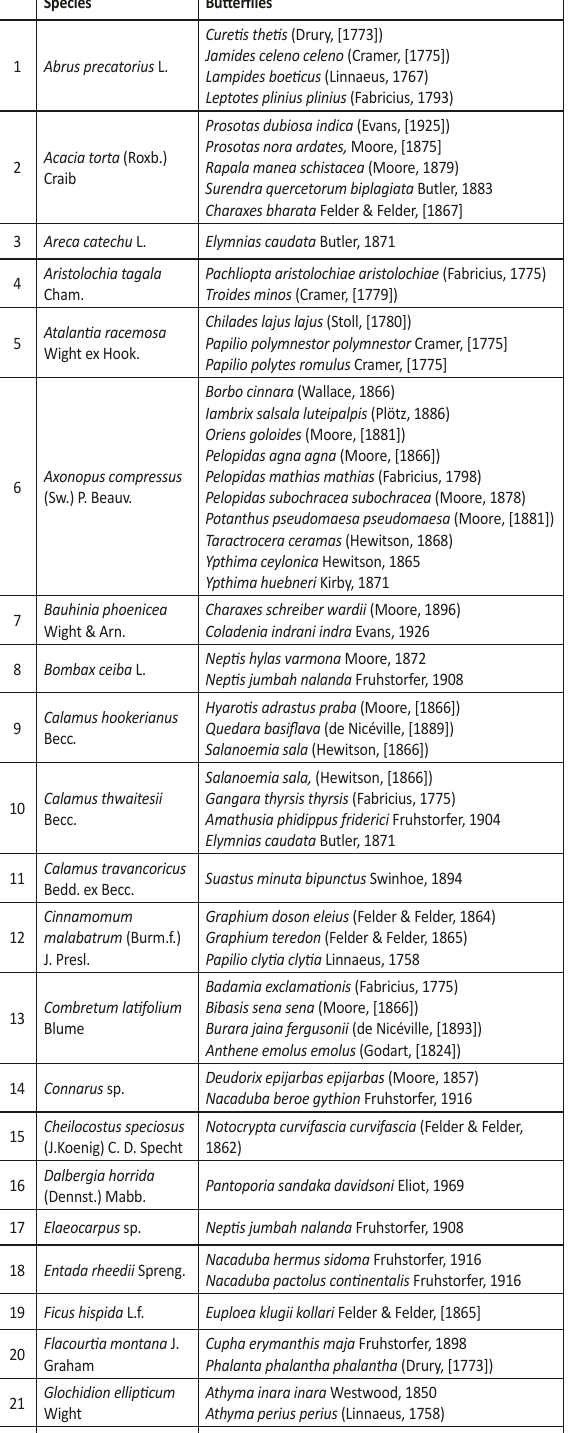
Table 3. List of larval host plants for butterflies of myristica swamp forests, Shendurney WS, recorded from our observations from 2008–2018. Species